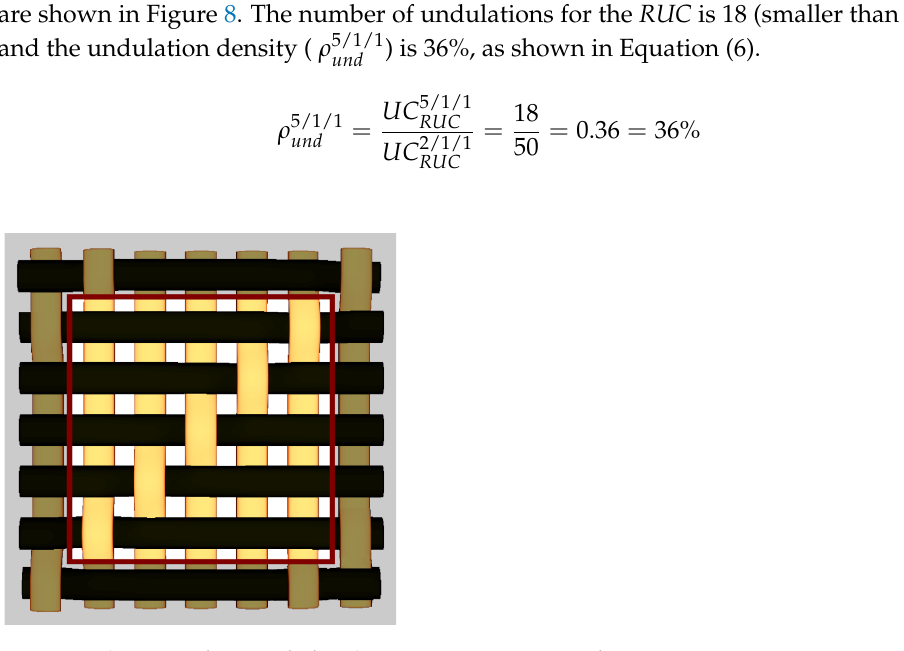
Table 6. The best solution found when using satin 4/1/1 fabric as reinforcement.